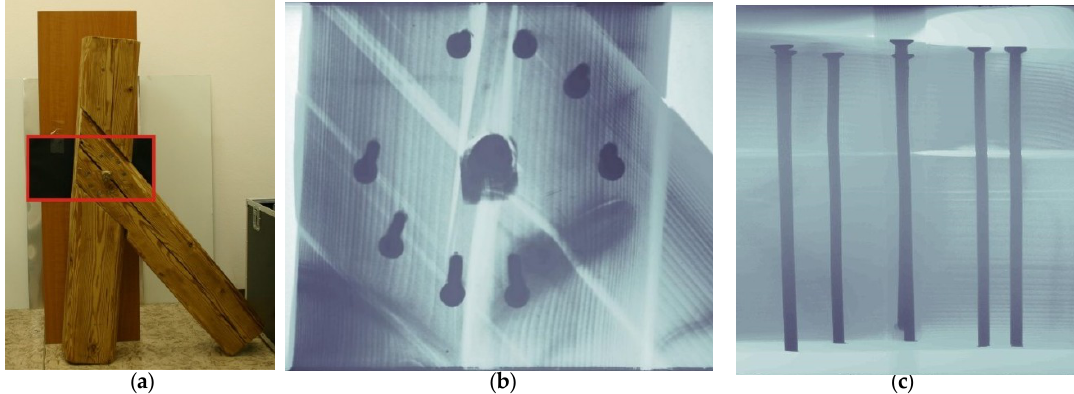
Figure 15. X-ray presentation of the deformed mild steel nails after the cycling tests of a joint: the ( a ) X-ray recording, ( b ) perpendicular view of the joint plane, and ( c ) cross-sectional view of the joint plane.